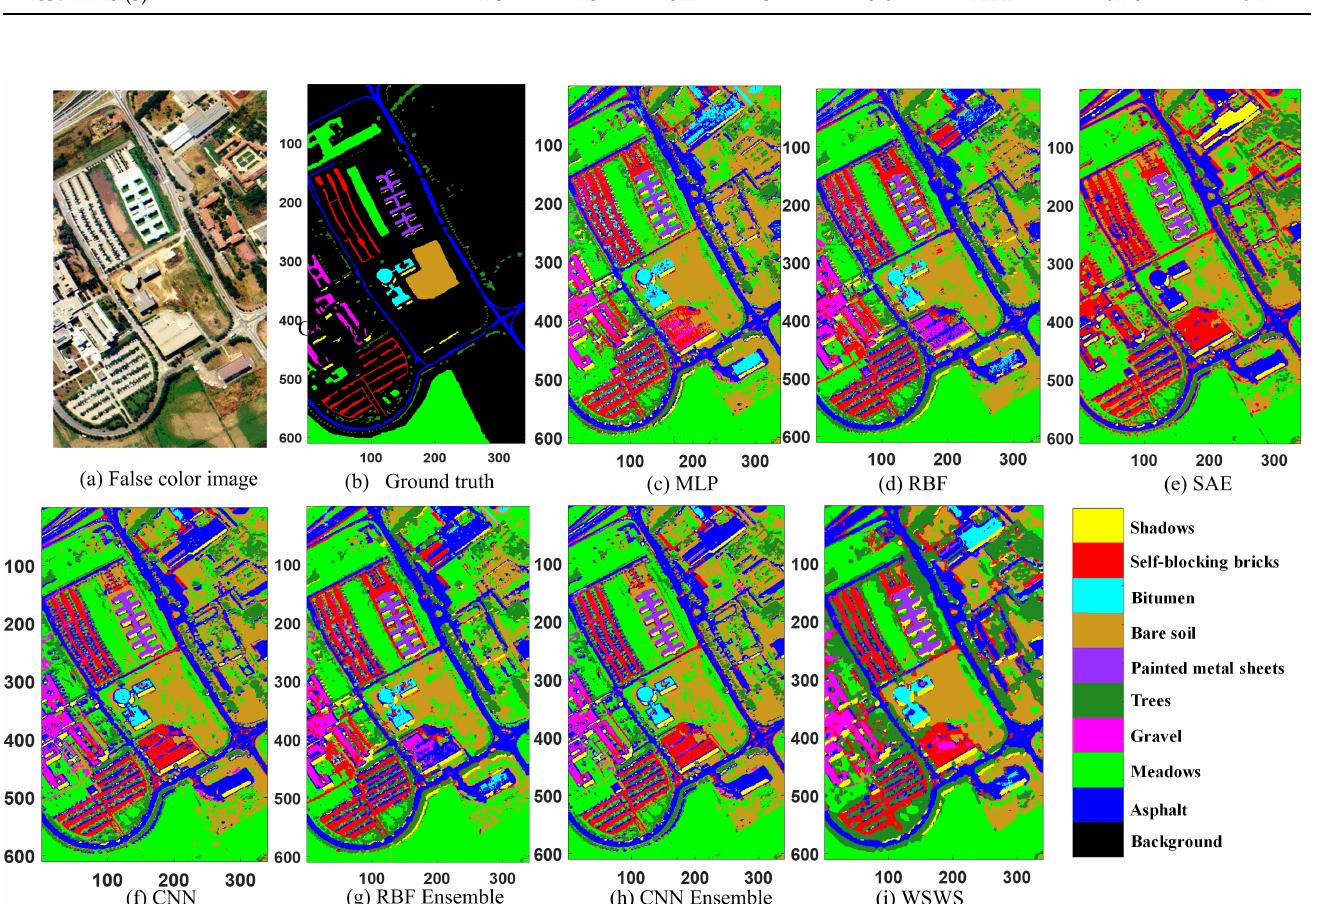
Figure 4. Classification results of Pavia University data. ( a ) Original image, ( b ) ground truth (there are no class labels for the black background), ( c ) multilayer perceptron (MLP), ( d ) radial basis function (RBF), ( e ) stacked autoencoder (SAE), ( f ) convolutional neural network (CNN), ( g ) RBE ensemble, ( h ) CNN ensemble, and ( i )